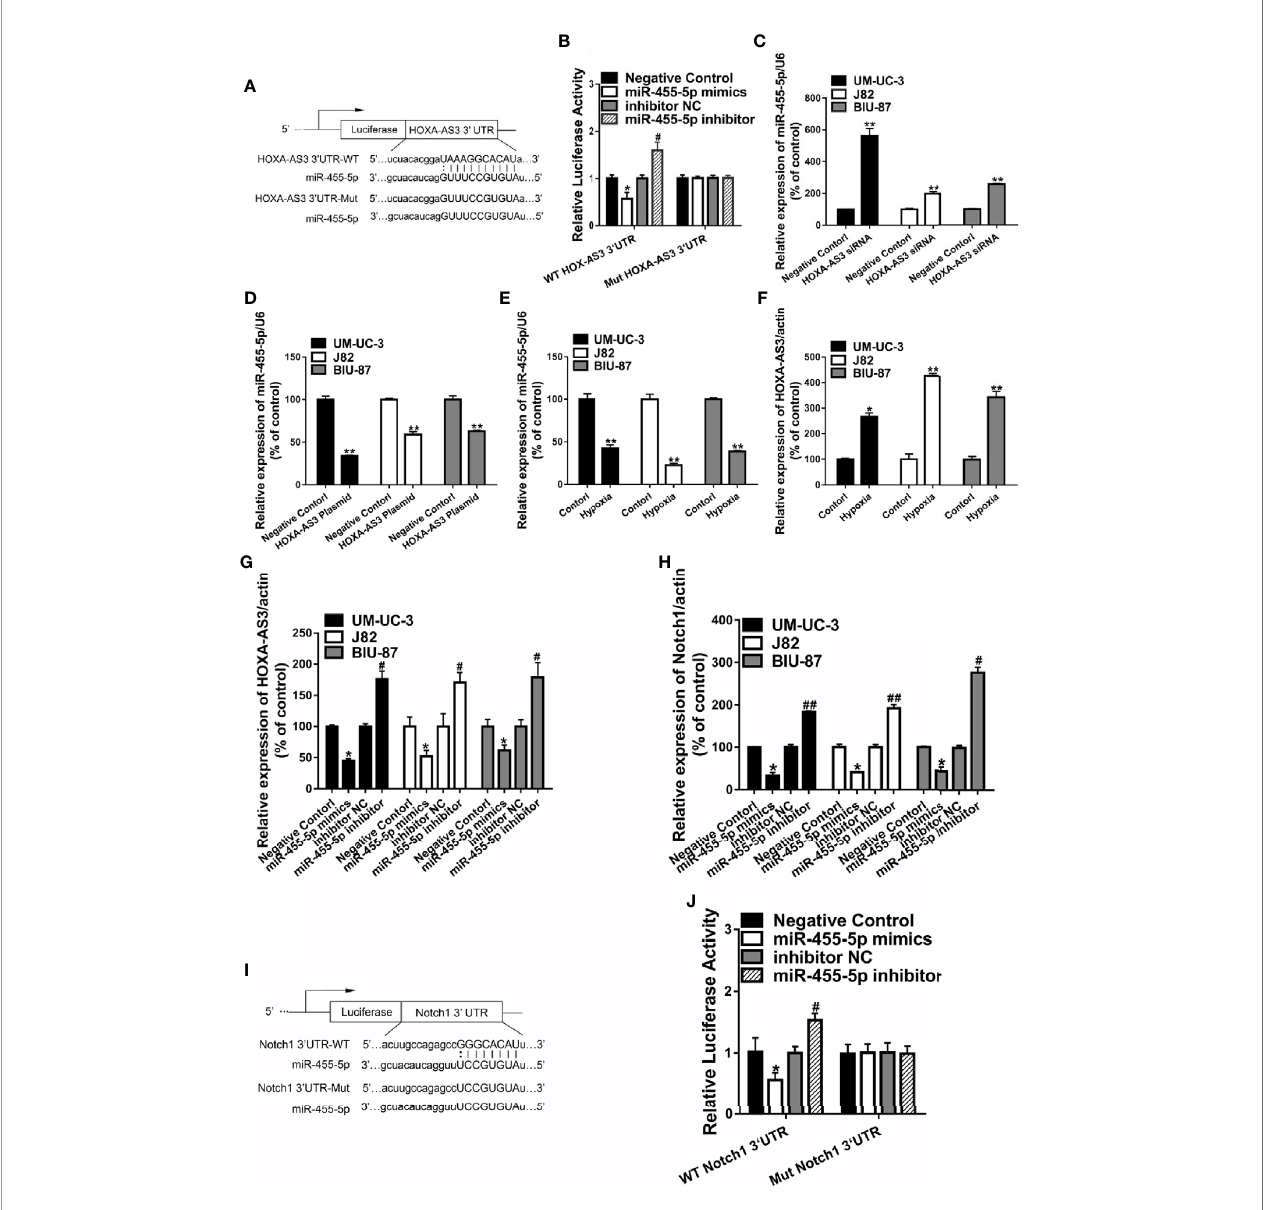
FIGURE 4 | HOXA-AS3 may function as a competing endogenous RNA of miR-455-5p. (A) The predicted binding site between HOXA-AS3 and miR-455-5p and the mutation in the predicted seed region. (B) Relative luciferase activity of bladder cancer (BC) cells co-transfected with WT-HOXA-AS3 or Mut-HOXA-AS3 and NC, inhibitor NC or miR-455-5p mimics, and inhibitor. *P < 0.05 vs . NC; # P < 0.05 vs . inhibitor NC. (C , D) Expression of miR-455-5p in BC cells transfected with HOXA-AS3 small interfering RNA (siRNA) or HOXA-AS3 detected by qRT-PCR. **P < 0.01. (E , F) qRT-PCR results showing the level of miR-455-5p and HOXA-AS3 under hypoxic or control conditions. *P < 0.05, **P < 0.01. (G) Expression of HOXA-AS3 in BC cells transfected with the miR-455-5p mimic or inhibitor detected by qRT-PCR. *P < 0.05 vs . negative control (NC); # P < 0.05 vs . inhibitor NC. (H) Expression of Notch1 in BC cells transfected with the miR-455-5p mimic or inhibitor, as detected by qRT-PCR. *P < 0.05 vs . negative control (NC); # P < 0.05, ## P < 0.01 vs . inhibitor NC. (I , J) Relative luciferase activity of BC cells co-transfected with WT-Notch1 or Mut-Notch1 and NC, inhibitor NC or miR-455-5p mimics, and inhibitor. *P < 0.05 vs . negative control (NC); # P < 0.05 vs . inhibitor